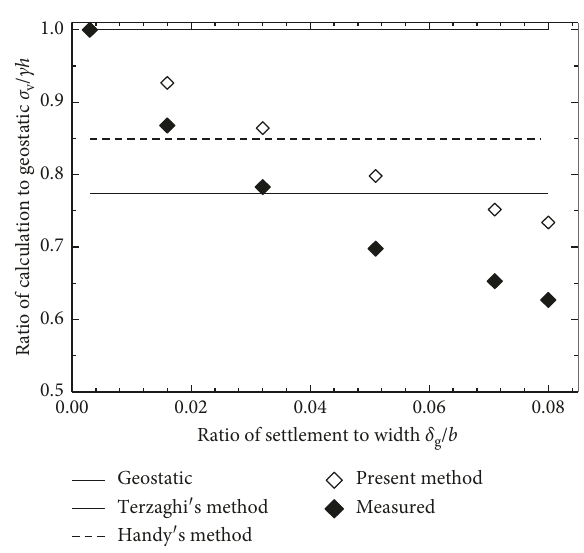
Figure 13: Comparison of load on the geosynthetic layer due to local subsidence.